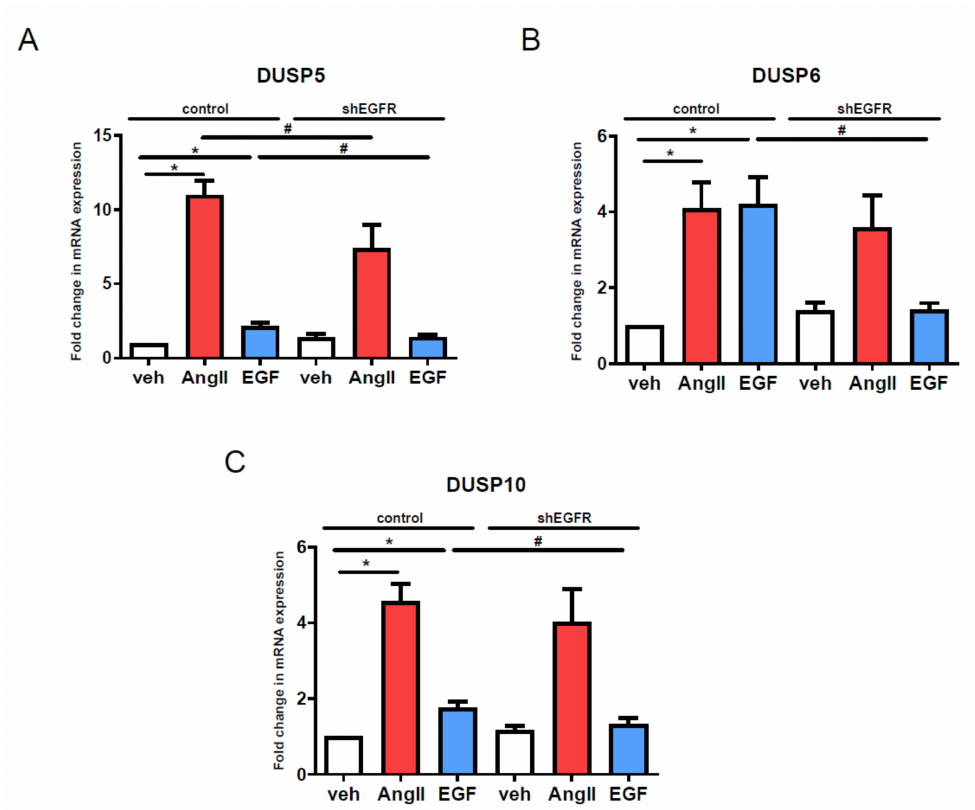
Figure 7. Effects of EGFR silencing on the gene expression responses to AngII and EGF stimuli in VSMCs. Primary vascular smooth muscle cells were infected with either scrambled (control) or shEGFR#2 (shEGFR) shRNA coding lentiviral particles for 48 h. Infected cells were stimulated for 2 h with either 100 nM AngII (red columns), or 50 ng/mL EGF (blue columns) or vehicle (white columns) after 24 h of serum starvation. RNA was isolated from VSMCs, then converted to cDNA. cDNA levels of DUSP5 ( A ), DUSP6 ( B ) and DUSP10 ( C ) were measured by qRT-PCR. Standardization was made against the GAPDH housekeeping gene. The mRNA levels were normalized to values of control virus- infected and vehicle-stimulated samples and expressed as fold change. Mean values ± S.E. are shown. Significance was determined with multiple linear regression. p < 0.05 was considered as statistically significant. *: Statistically significant from vehicle stimulation. #: Statistically significant from control virus-infected agonist-induced response. The values are from four independent experiments ( n =